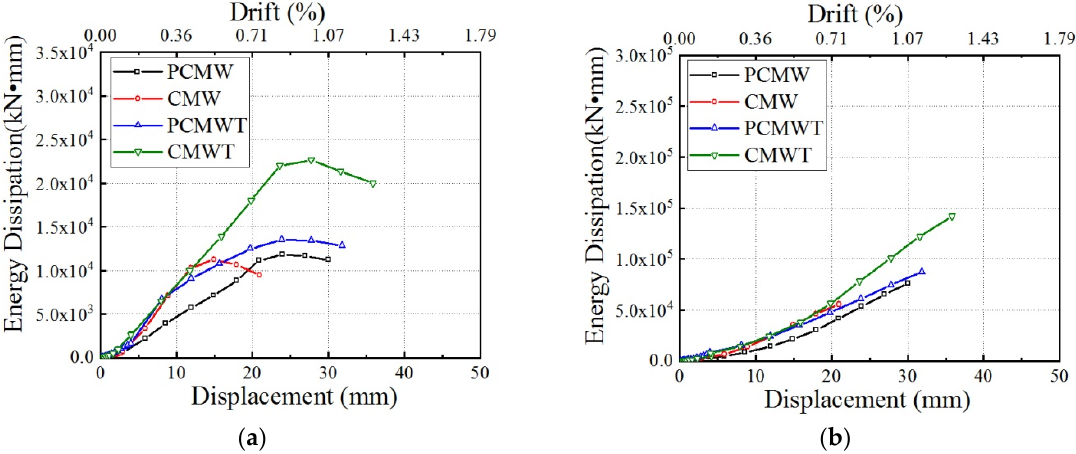
Figure 11. Energy dissipation: ( a ) single cycle and ( b ) cumulative.